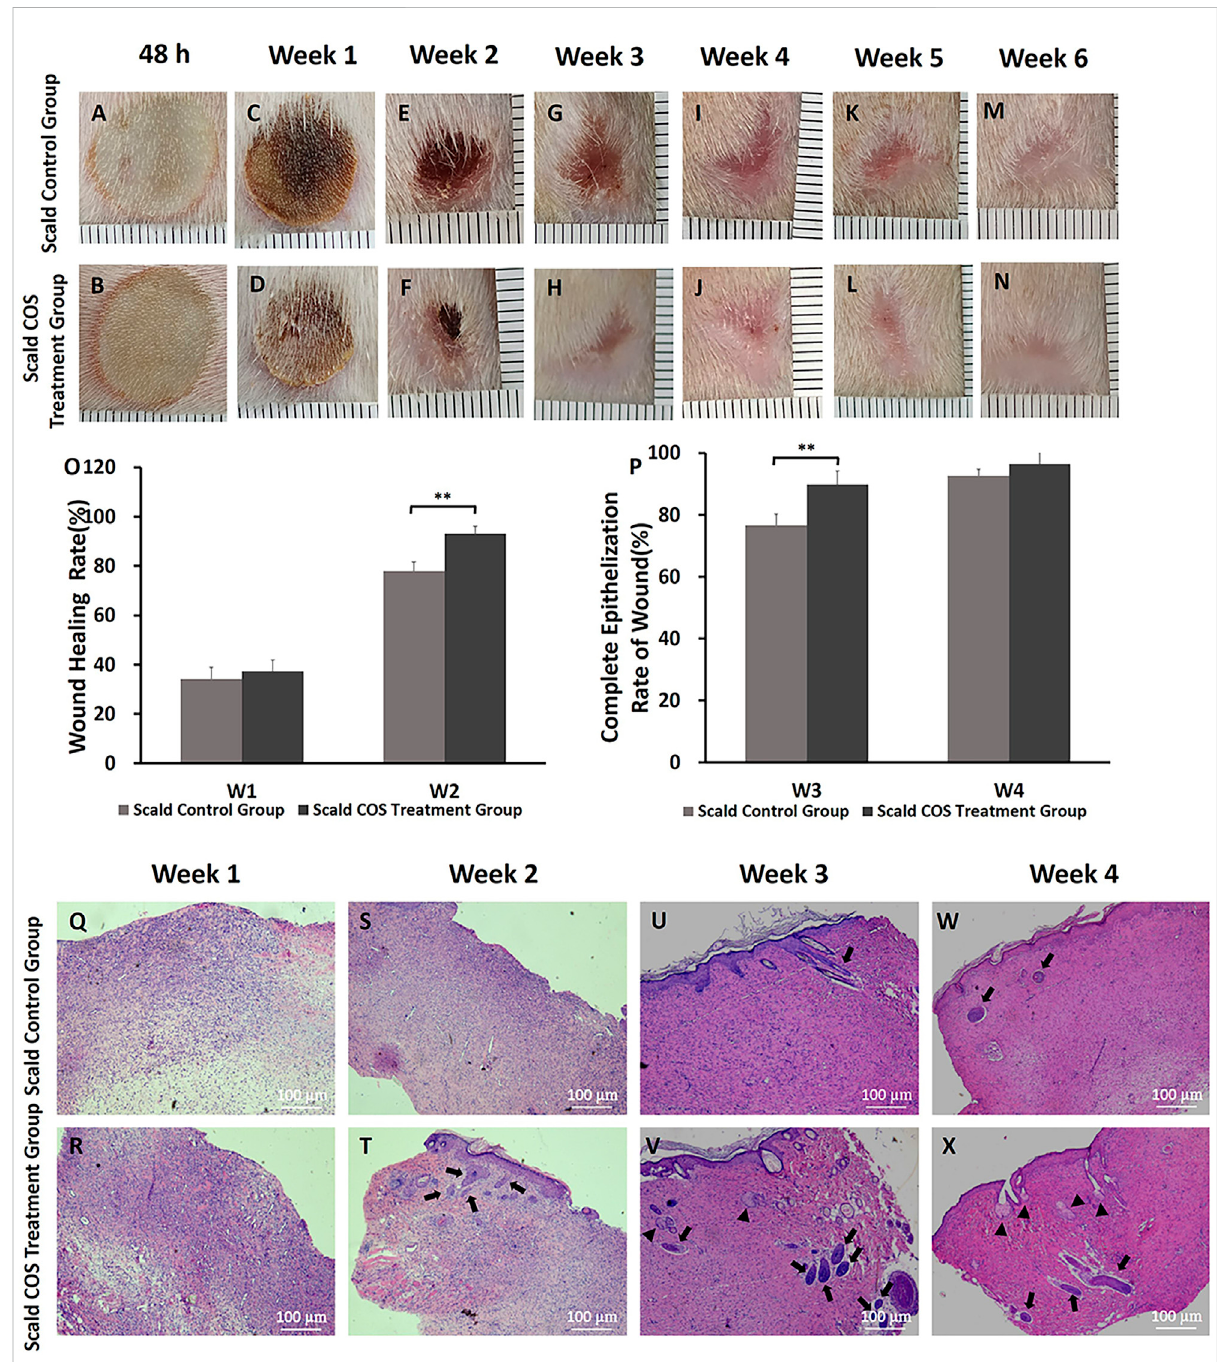
FIGURE 2 Wound healing, wound healing rate, complete epithelialization rate of burn wounds, and histopathology analysis in rats (A – N) Typical wound images of rats in the two scald groups within 6 weeks after injury. (O) Wound healing rate in the fi rst week and the second week after injury (P) Complete epithelialization rate on thethird weekand thefourth weekafter injury. ** p < 0.01. (Q – X) H&E staining ofwounds of thetwo scald groups onthe fi rst4 weeksafterinjury.ThenumberofnewbornsebaceousglandsandhairfolliclesintheCOS-treatedgroupwasmorethanthatinthe scald control group. Triangles point sebaceous glands, and thick arrows point newborn hair follicles. The scale bar represents 100